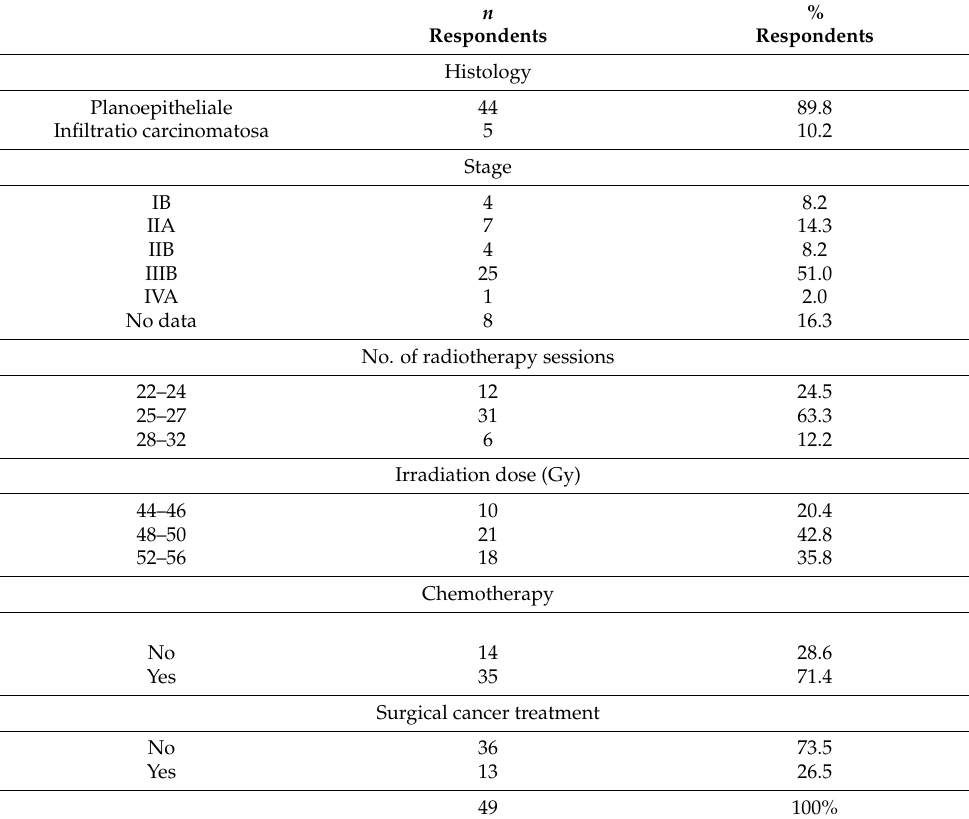
Table 2. Clinical characteristics of the study